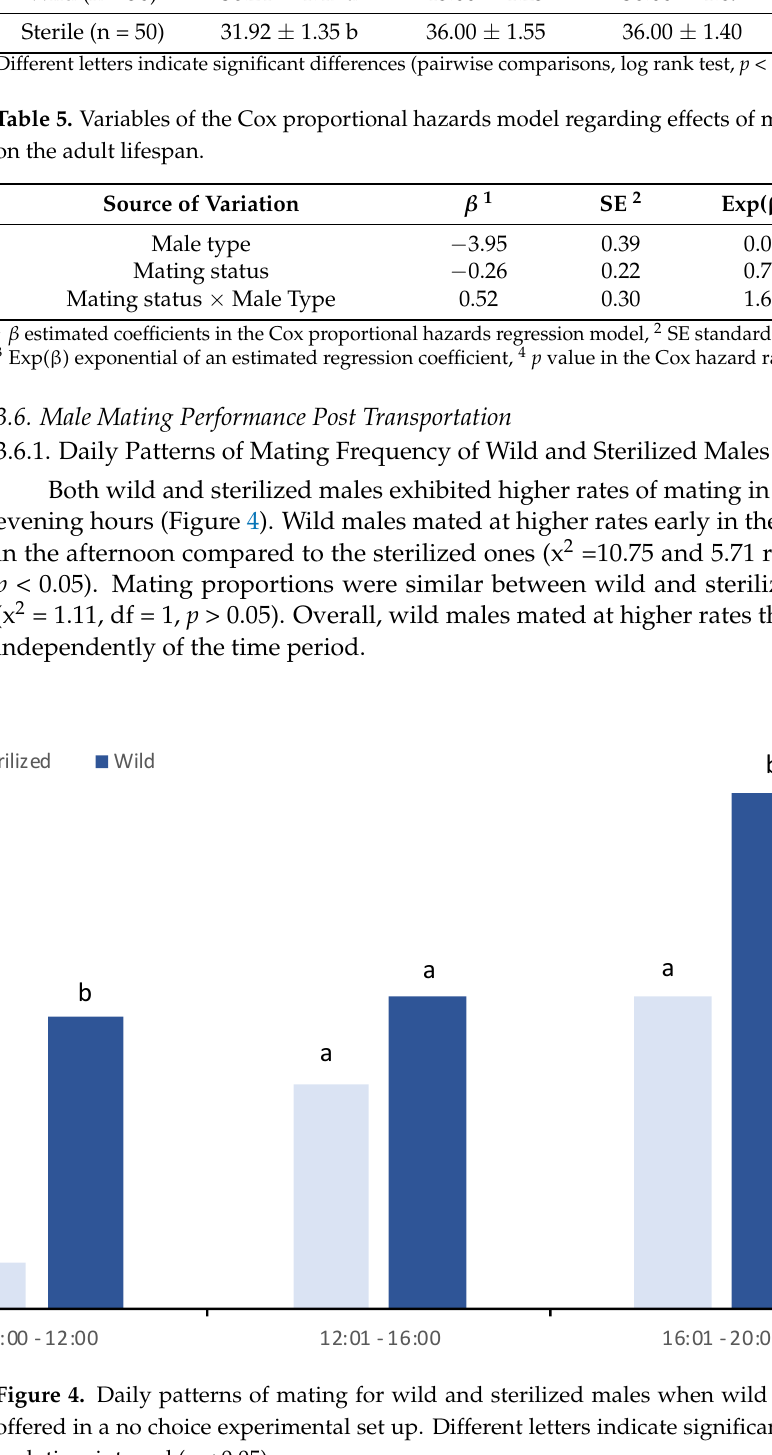
Figure 5. Effect of time of the day on copulation duration for wild and sterilized males when wild virgin females were offered in a no choice experimental set up.